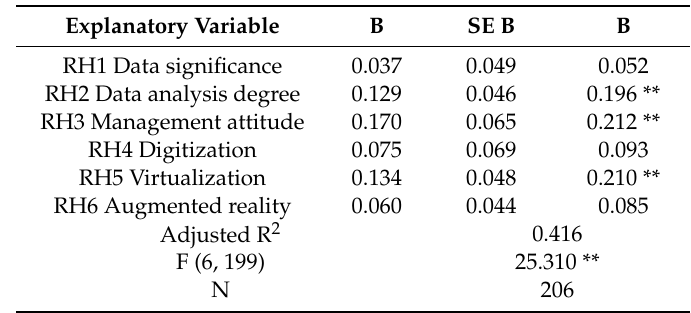
Table 6. Linear regression